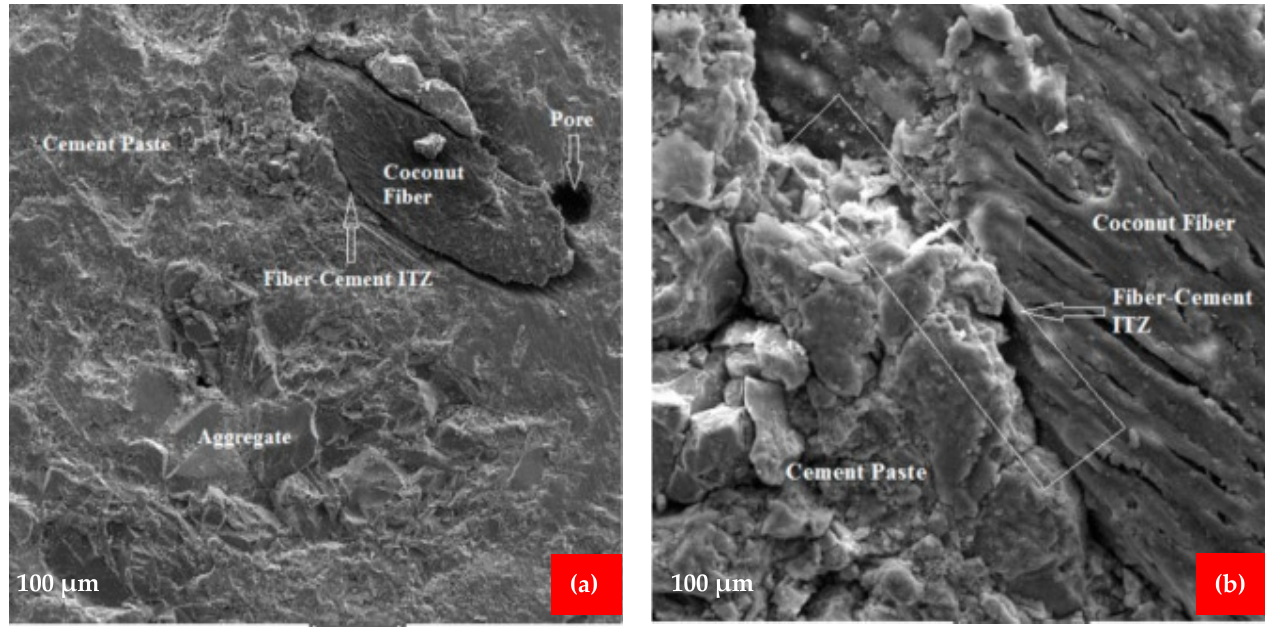
Figure 17. ( a ) Pore in ITZ, ( b ) CF paste ITZ [50].